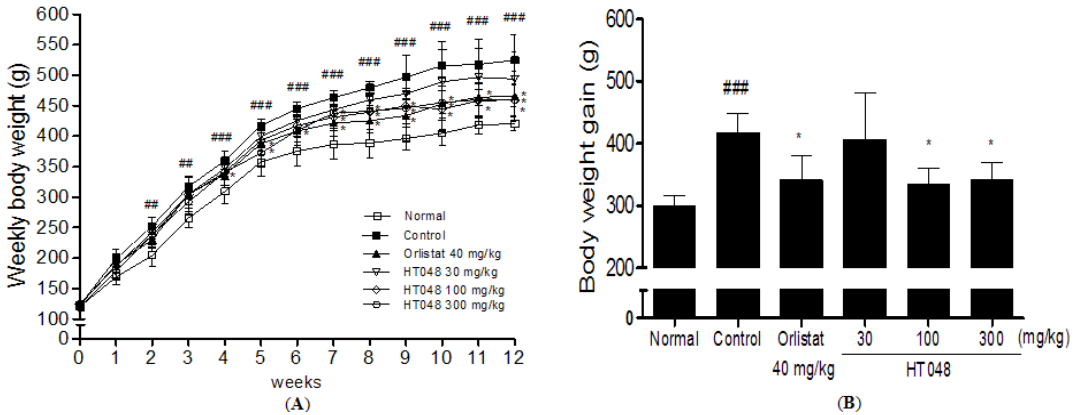
Figure 3. ( A ) Effects of HT048 on body weight (g), ( B ) body weight gain (g) ( C ) and food intake (g/day) in HFD induced obese rat. The body weight of the animals was recorded weekly during the experimental period. The body weight gain was calculated by the equation: final body weight—initial body weight. The food intakes were measured on a per-cage basis throughout the study every 2 or 3 days. Data are mean ± SD values (n = 10 per group). ### p < 0.001, significant difference from the normal diet group. * p < 0.05, significant difference from the HFD-control